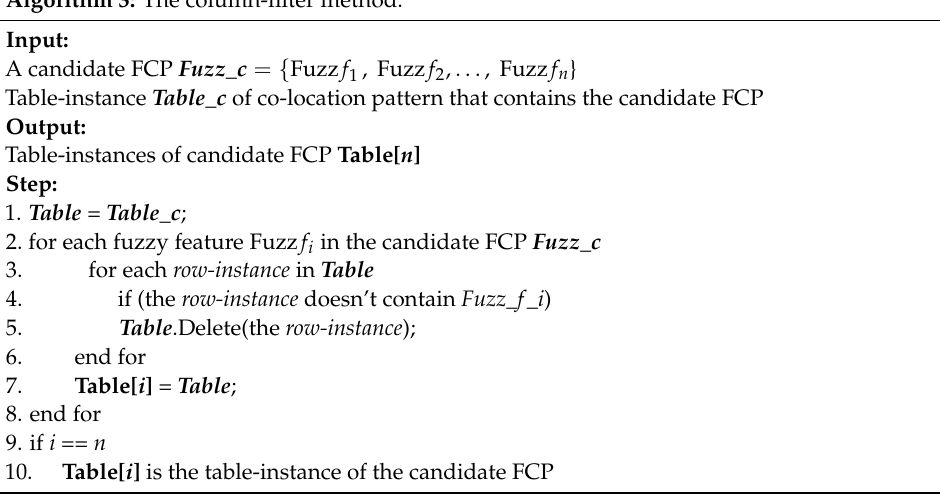
Algorithm 3: The column-filter